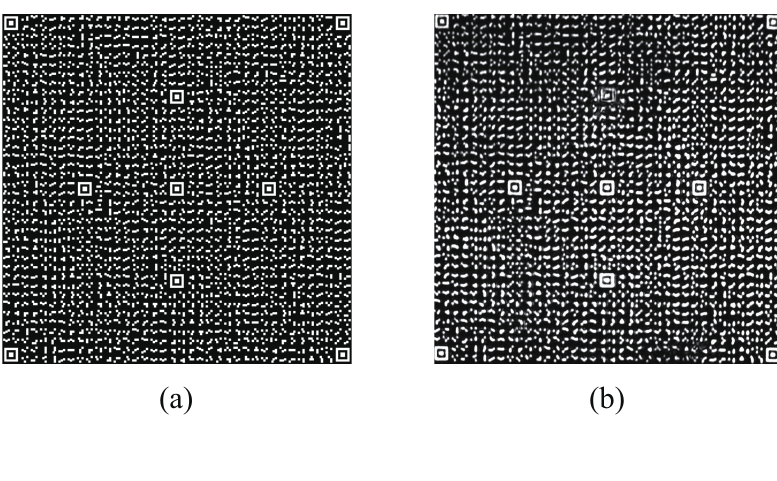
Figure 10. Original and reproduction image. ( a ) Original; ( b )